Question: Based on the figure, does the quantity rise or fall?
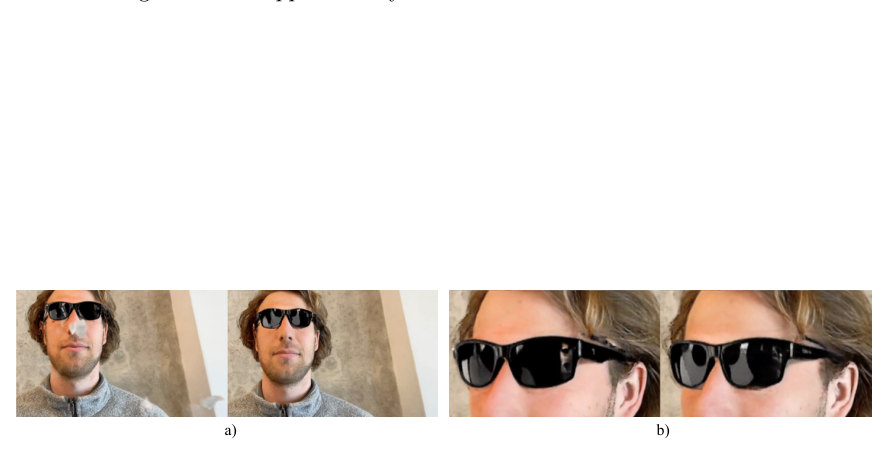
Answer: increasing